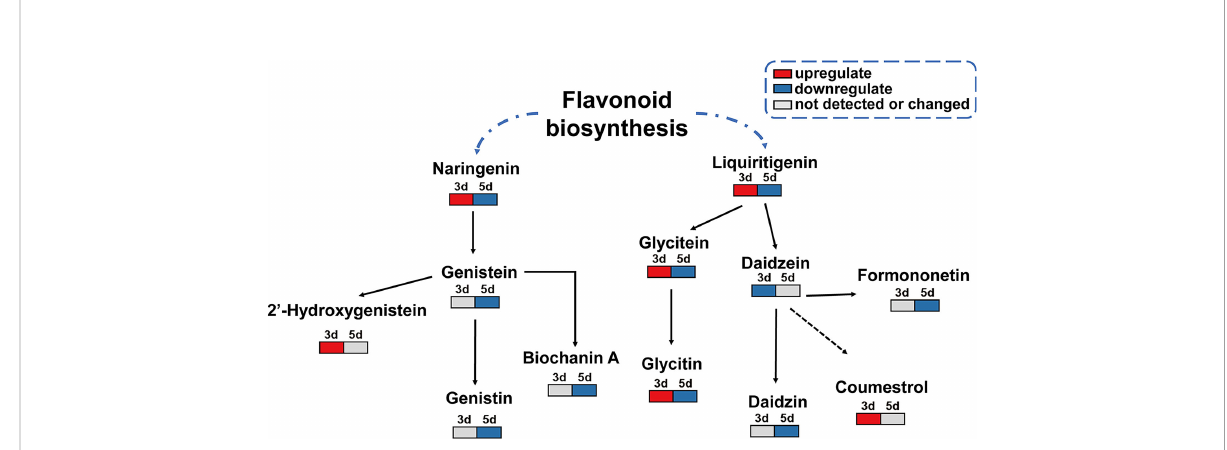
FIGURE 8 Change model of the key metabolites in the iso fl avone biosynthesis pathway. Gray box means undetected or changed metabolites at the indicated time points; the red box indicates the upregulated differential metabolites, and the blue box stands for the downregulated differential